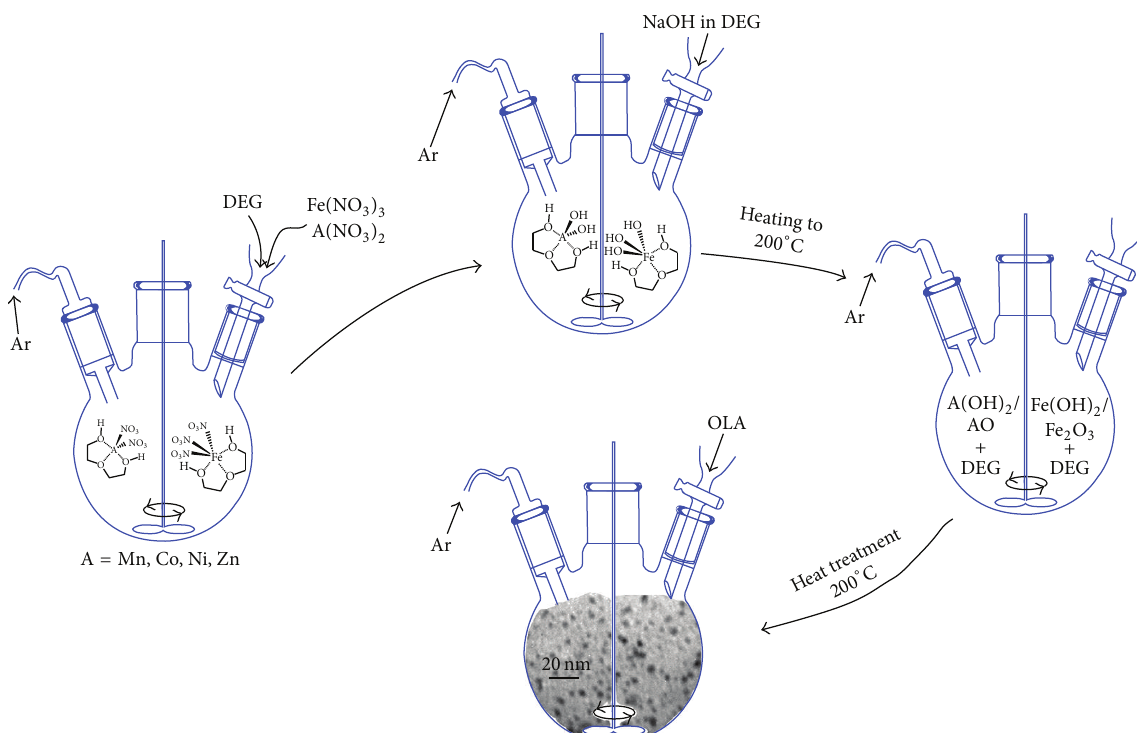
Figure 1: Synthesis scheme from diethylene glycol solutions for NPs of AFe 2 O 4 (A = Mn, Co, Ni, Zn) spinel ferrites.